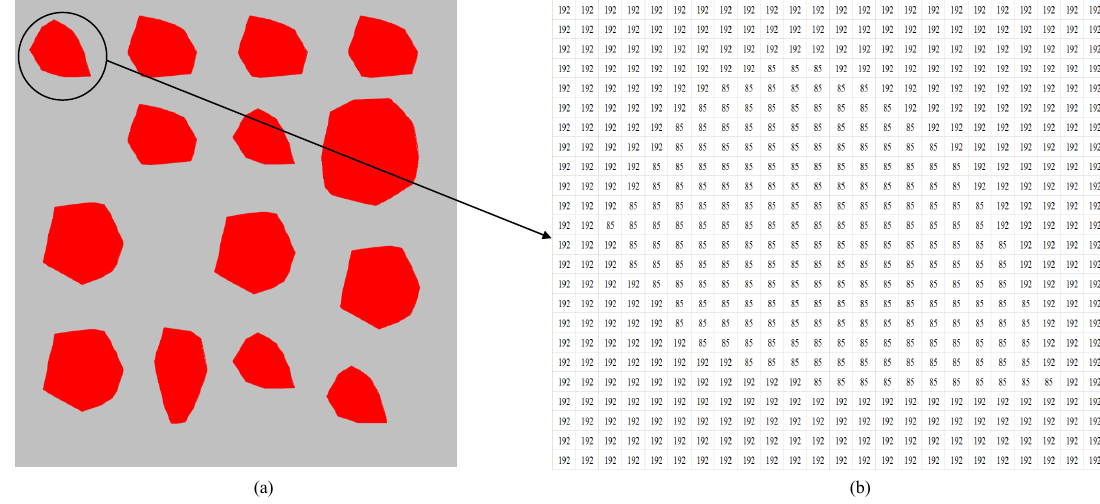
Fig. 5 Typical slice of RAM of concrete (a) and the corresponding color matrix (b) Figure 5. Typical slice of RAM of concrete ( a ) and the corresponding color matrix ( b